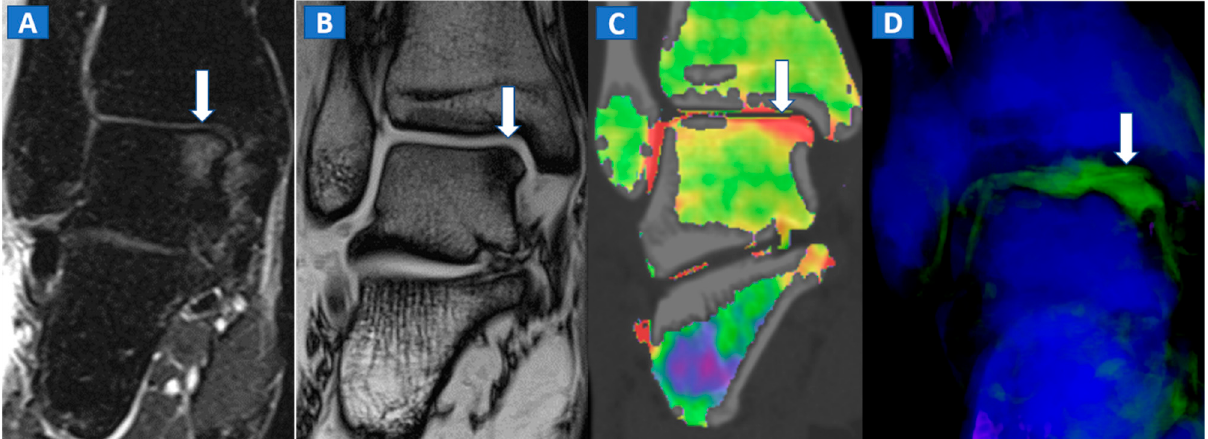
Figure 7. A 44-year-old male with post-traumatic OCL of the talar dome. On the coronal STIR MRI image ( A ), a hyperintense subchondral area of BME is depicted on the medial aspect of the talar dome (arrow), which is consistent with the diagnosis of OCL of the talus. The lesion appears hypointense on the T1-weighted images ( B ; arrow). On the 1 mm reconstructed 2D coronal DECT image ( C ) and coronal 3D DECT map, the lesion appears as a subchondral oedematous area (arrow), due to its increased water content. On the corresponding 3D image ( D ) the BME is coded in green (arrow).